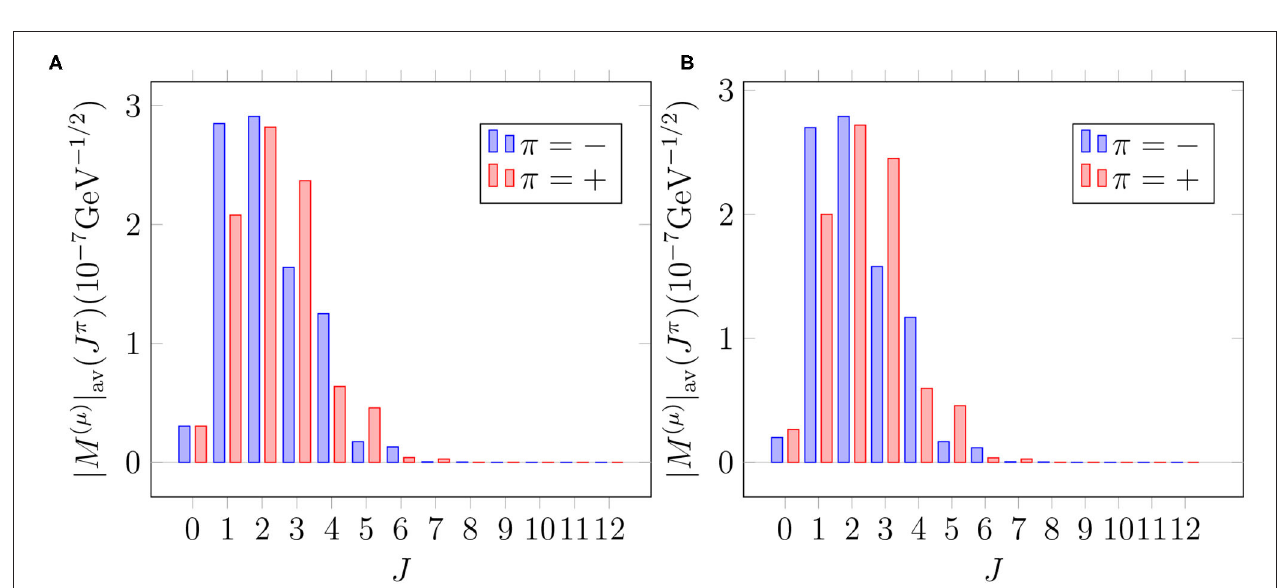
FIGURE 3 | Multipole decomposition of the total 0 νβ + β + -decay matrix element in different single-particle bases. The decompositions correspond to the parameter value g ( T = 0) pp = 0.7. (A) Basis: “Adj.”. (B) Basis: “WS”.